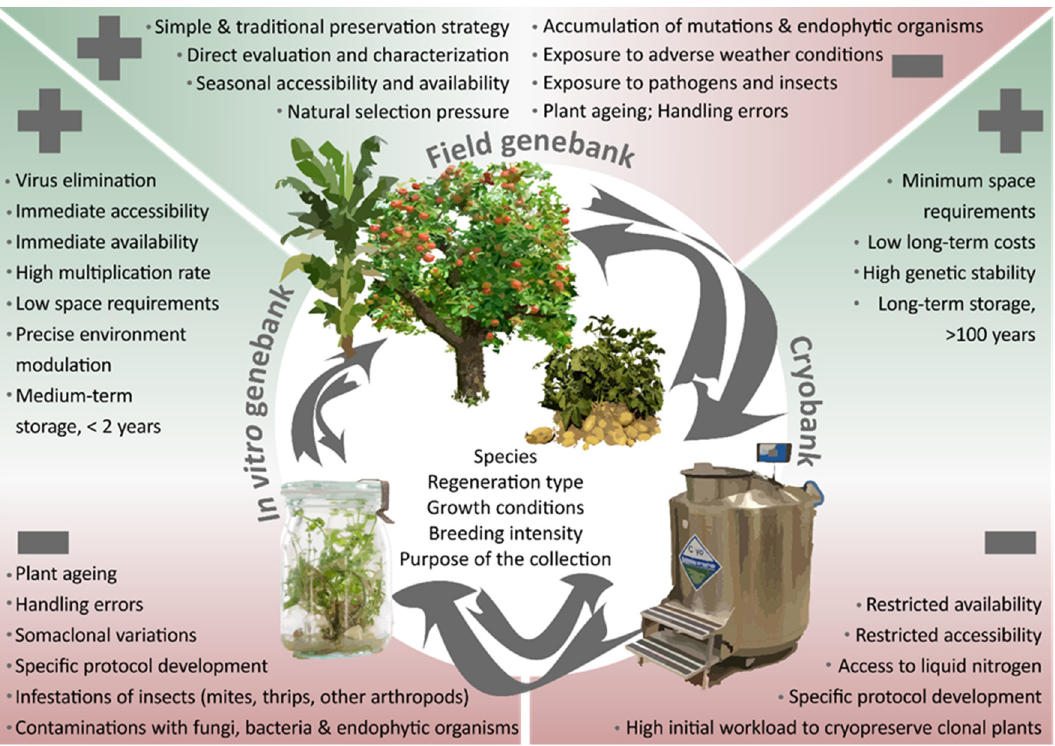
Figure 1. Pros and cons of storing crop genetic resources in field genebanks, in vitro and through cryopreservation. Arrows indicate the potential source material and target approach to maintain plant genetic resources for food and agriculture (PGRFA) and can be specific for each plant species.